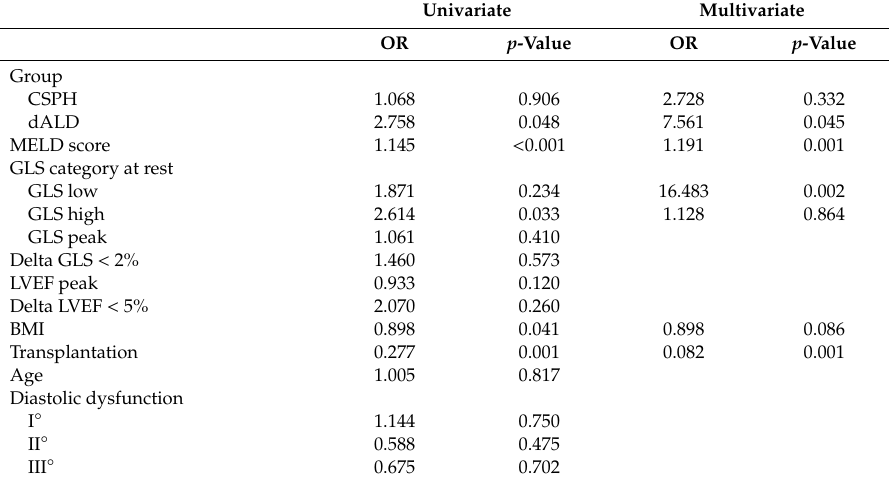
Table 4. Parameters that could predict mortality. Univariate and multivariate Cox regression analysis displaying odds ratios (ORs) und p